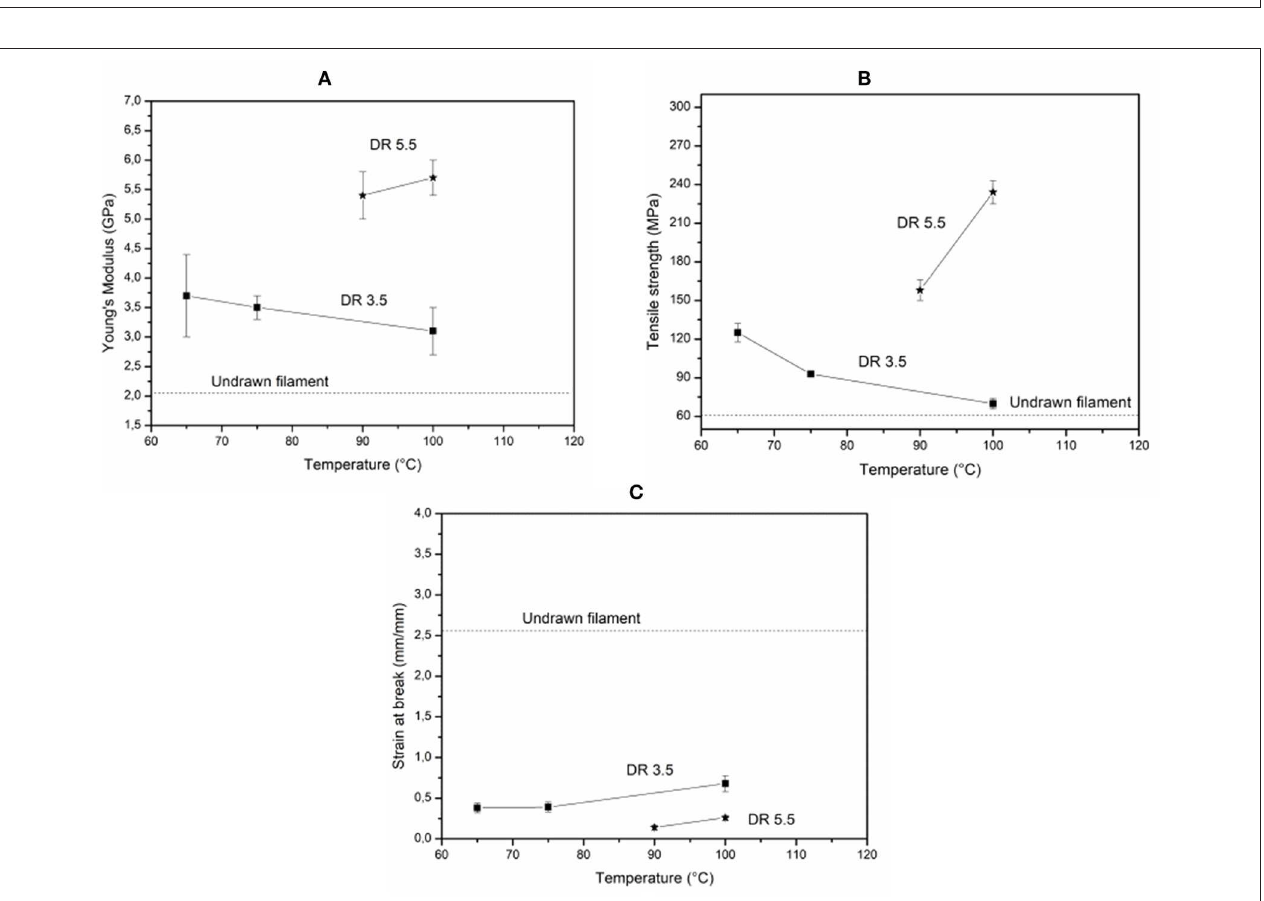
Samples morphology was investigated by Scanning Electron Microscopy (SEM) in a Phenom World Pro X microscope from lateral surfaces of both undrawn and drawn filaments. Conventional SEM as well as topographical images were obtained.